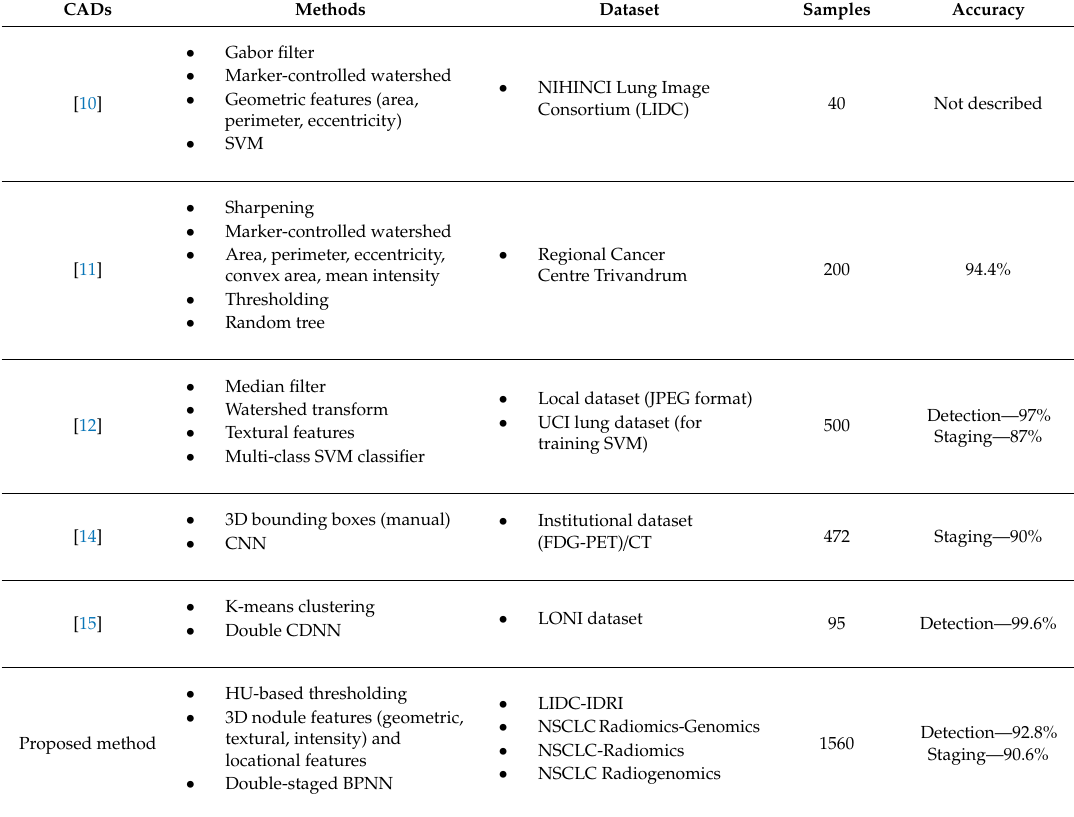
Table 7. Quantitative performance comparison of the proposed CAD method with methods presented in previous